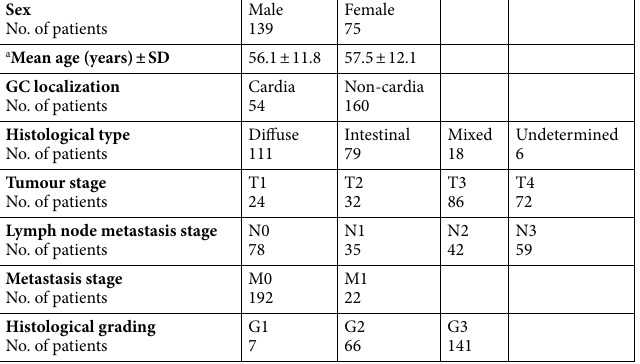
Table 1. Available clinicopathological characteristics of patients with gastric cancer. T tumour, N node, M metastasis, G grade 22 . a Age at first